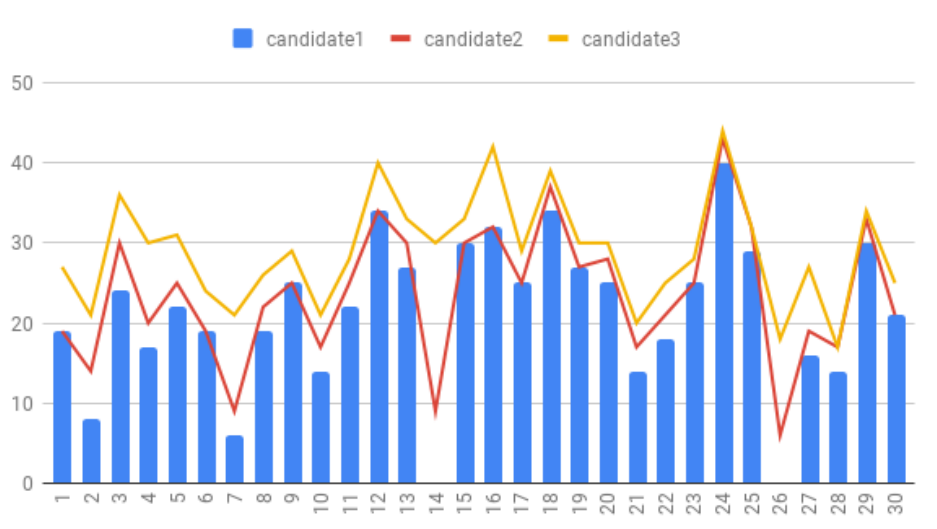
Figure 17. Results of the Equation (1) by applying the three-steps